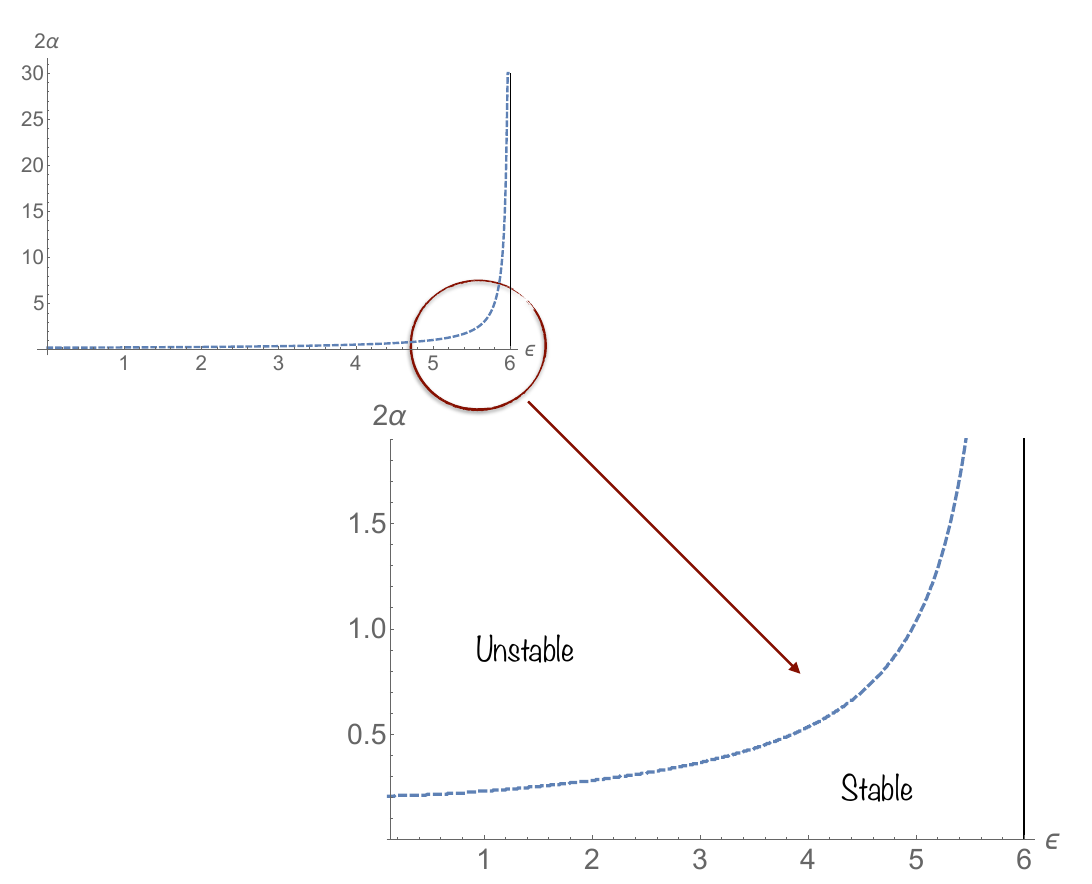
Figure 2 . We have shown the phase diagram in the f (cid:15); (cid:11) g -plane. The blue dashed curve is the pictorial representation of (cid:21) (0) a ( (cid:15); (cid:11) ) R 2 = (cid:0) 1 , the black vertical line corresponds to (cid:15) = (cid:15) max . (cid:6) 4 Stable and unstable regions are also marked. The critical value of (cid:11) diverges near (cid:15) ! (cid:15) max , as (cid:11) crit (cid:24) ( (cid:15) max (cid:0) (cid:15) ) (cid:0) 1 = 2 . the bulk are, in principle, identi(cid:12)able with a precise boundary theory operator. In